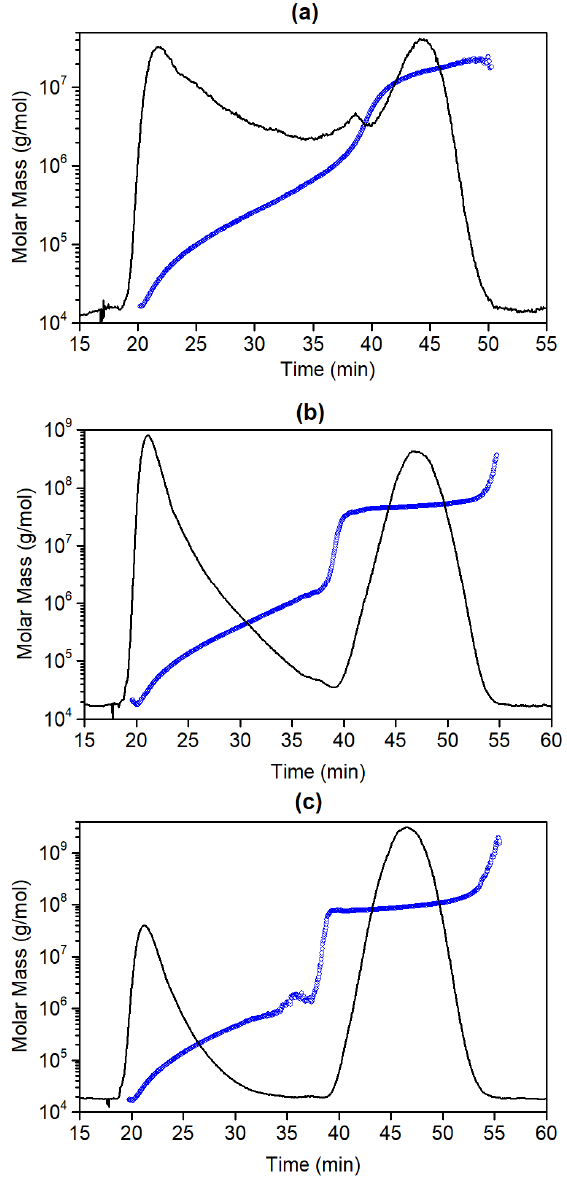
Figure 4. Molar mass (blue) versus retention time plots overlaid on RI fractograms (black) of reference latex copolymer ( a ) and copolymers modified with 20 wt. % of AME_OA ( b ), and 20 wt. % AME_RO ( c ).